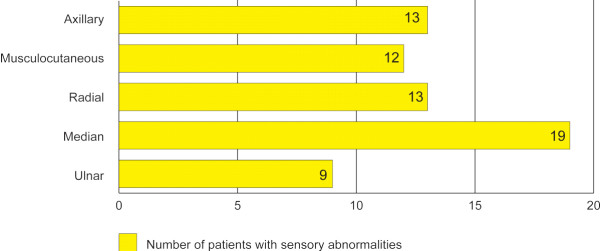
Sensory abnormalities (pain, touch, and/or vibratory sense) in 21 dominant limbs.